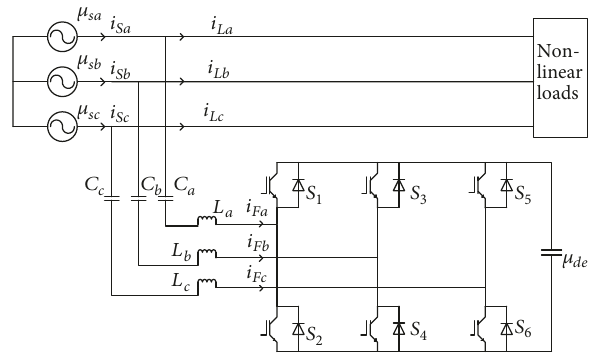
Figure 1: Mathematical model of SHAPF